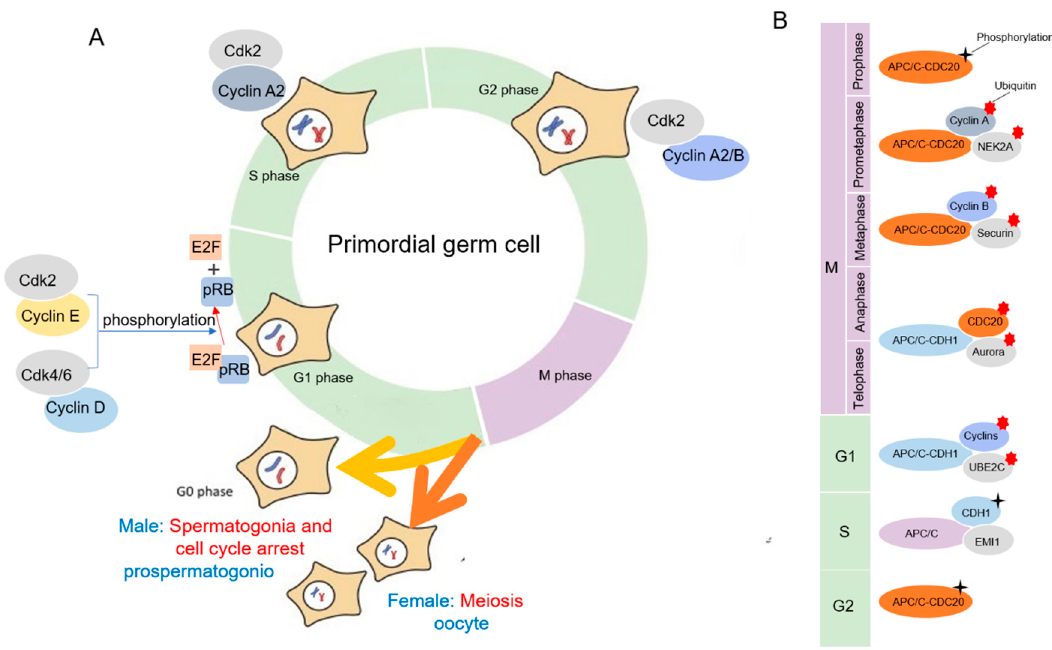
Figure 2. A . Illustration of the main cell cycle genes expressed and likely controlling the cell cycle in proliferating mouse PGCs. B . The role of APC/C in the cell mitosis